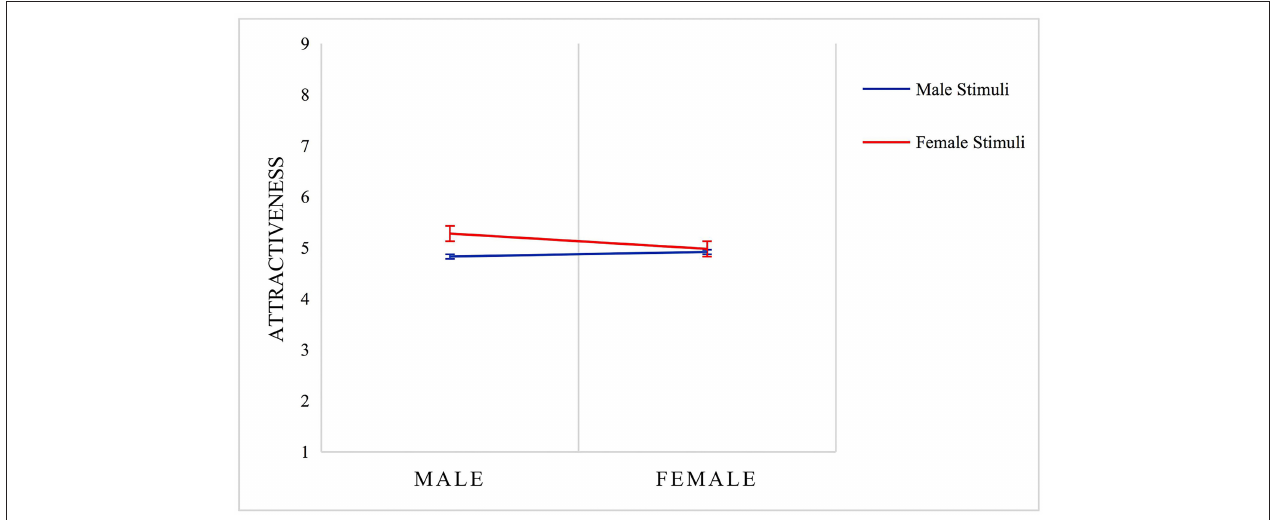
FIGURE 4 | MANOVA analysis of attractiveness of different-sex multimodal stimuli × different-sex raters in Study 2. Error bars indicate standard errors of the